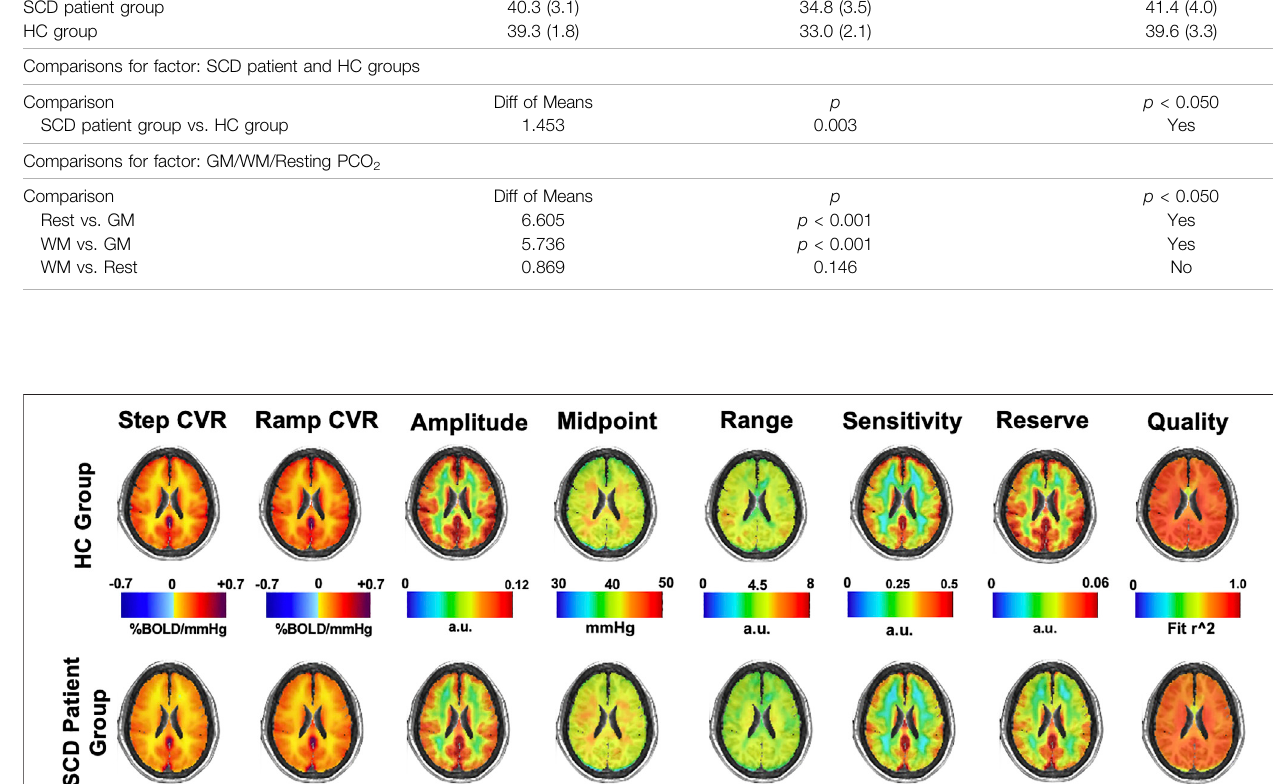
Frontiers in Physiology |